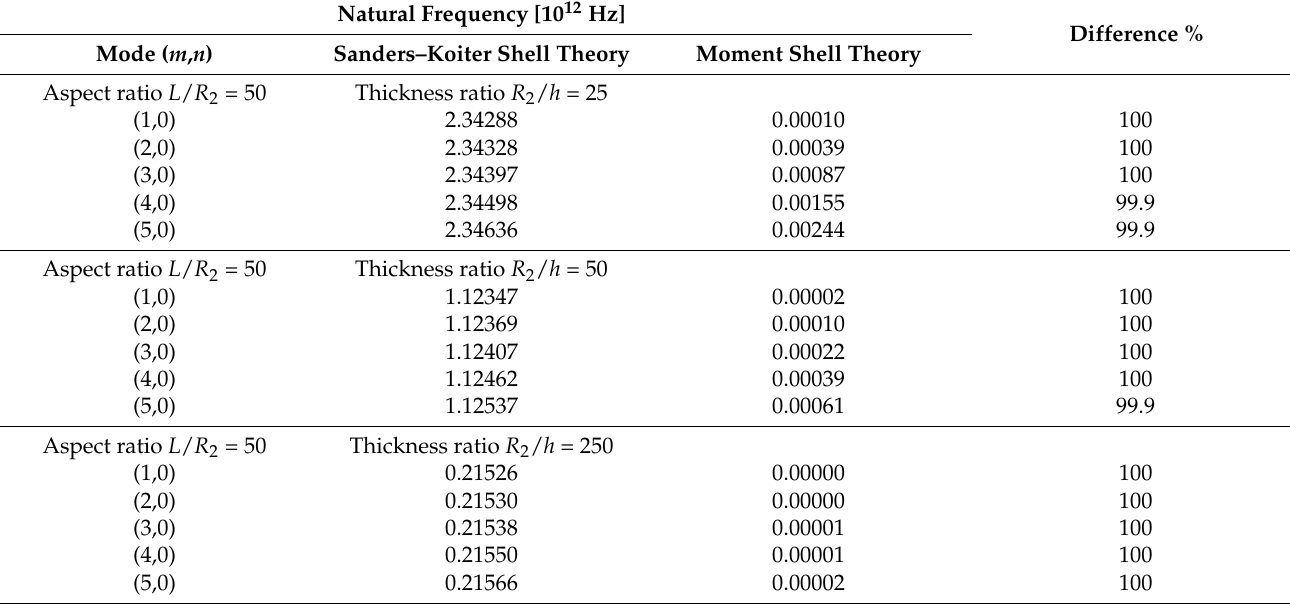
Table 7. Simply supported DWCNT with aspect ratio L / R 2 = 50 and thickness ratios R 2 / h = (25,50,250). Axisymmetric modes ( n = 0). Comparisons between Sanders–Koiter and moment shell